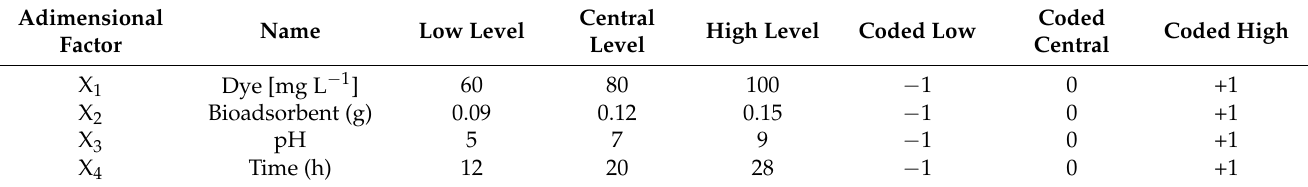
Table 1. Intervals of experimental conditions of the variables and levels for the process of adsorption of Congo red dye. Adimensional